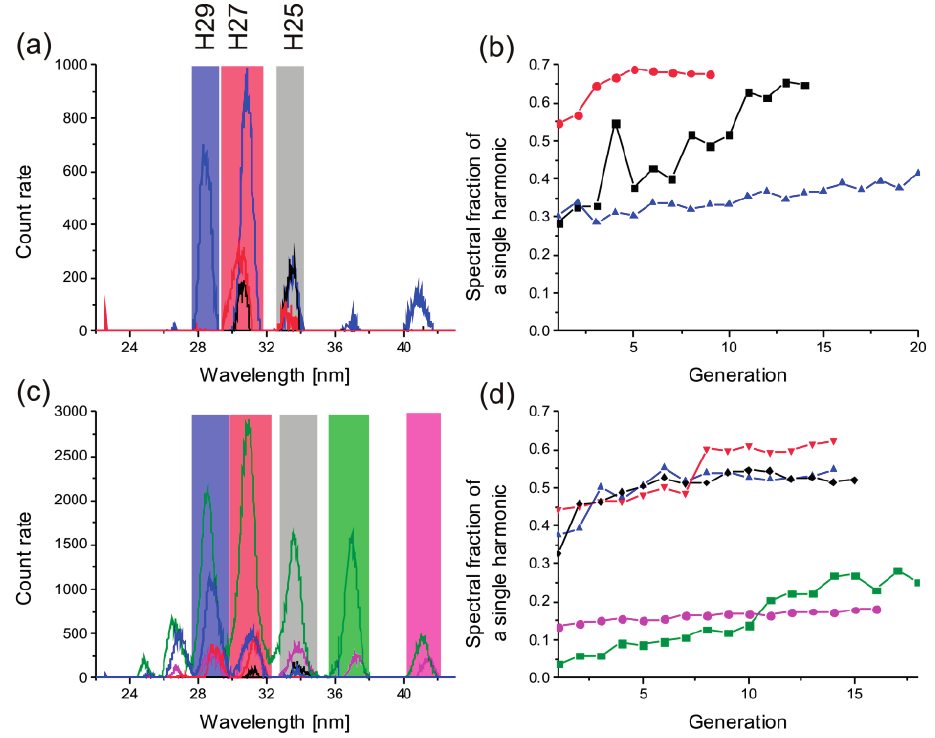
Figure 7. Optimization of single harmonics for ( a ) argon broadened and ( c ) SF 6 broadened shaped pulses. The colored areas show the chosen spectral area for the optimization and the respective optimization result is shown as a line plot. The accompanying development of the fitness is shown in ( b ) and ( d ) in the same color as the optimized spectra. In case of using SF 6 the spectral fraction of 25th to 29th harmonic can be optimized over